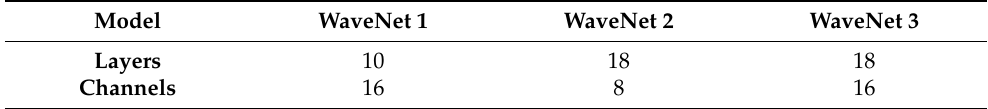
Table 1. Feedforward WaveNet configuration summary. The nomenclature for these configurations is not generalized, and the names used here are taken from [26]. Model WaveNet 1 WaveNet 2 WaveNet 3 Layers 10 18 18 Channels 16 8